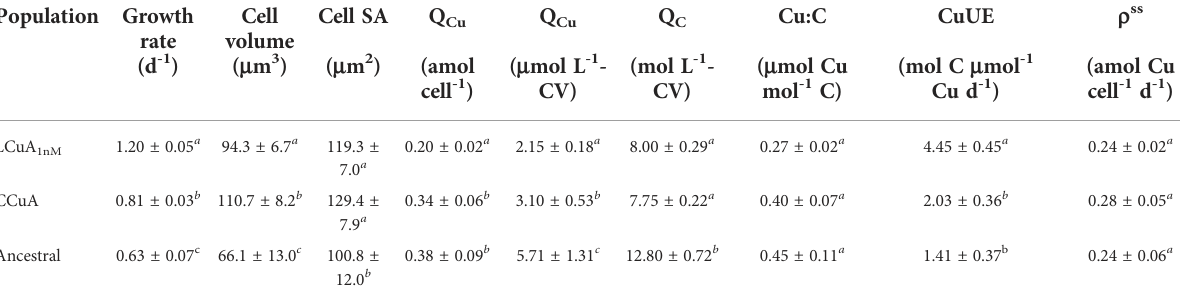
Valuesreportedaremeans±1SDoftento fi fteenbiologicalreplicatesofgrowthrateandthreeindependentbiologicalreplicatesofcellvolume-normalizedcarbon(Q C )andCu(Q Cu )quota. Coppertocarbonratio(Cu:C),Cuuseef fi ciency(CuUE)andsteady-stateCuuptakerate( r ss )werecalculatedusingthemeansofgrowthrate,Q C andQ Cu witherrorpropagation.Different lowercase letters indicate a signi fi cant difference among physiological traits of the populations (p<0.05, ANOVA).